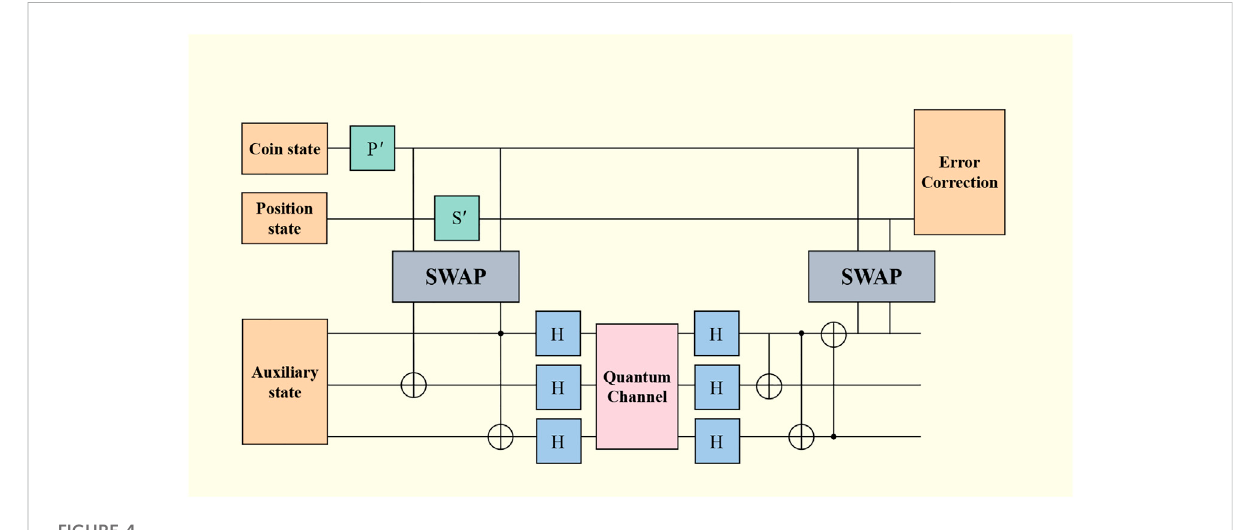
FIGURE 4 Quantum walk error correction circuit diagram. During the quantum walk, the particles are swapped into another lattice via the SWAP gate, which is then swapped into the lattice of quantum walk after correcting the coin state and the initial state by the quantum error-correcting code.